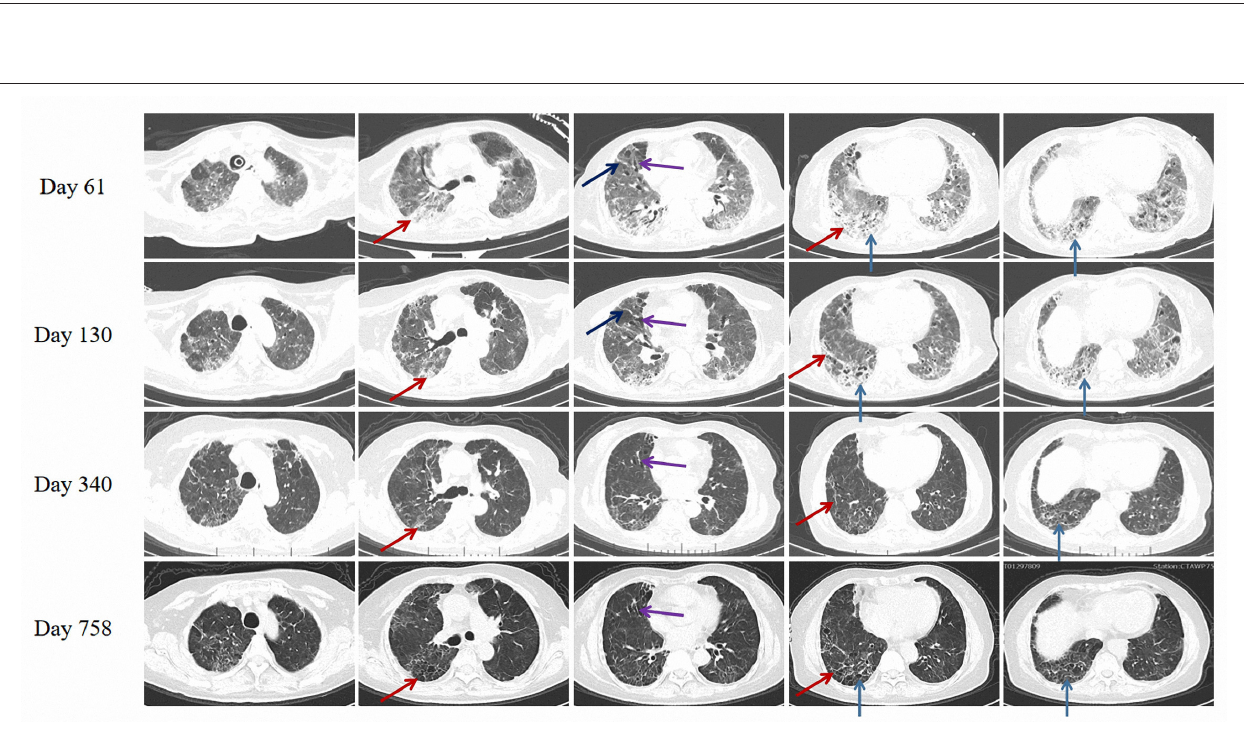
FIGURE 2 | Chest CT on day 61 (Starting taking pirfenidone), day 130 (At discharge), day 340 and day 758 after illness onset. Red solid arrows: subpleural reticular abnormalities and fibrous cords. Black solid arrow: interlobular septal thickening. Purple solid arrow: traction bronchiectasis. Blue solid arrow: honeycomb-like change under the